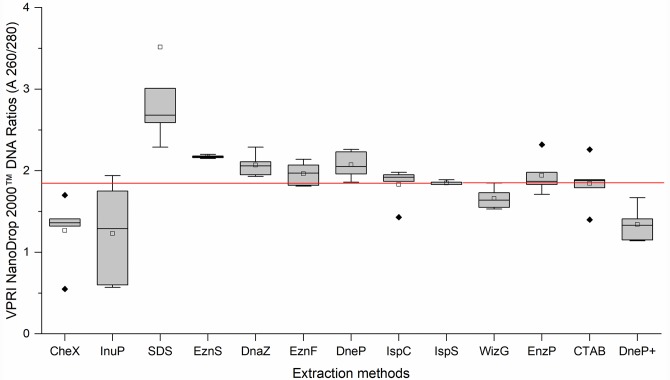
Boxplots of the DNA quality measured by thermo scientific nanodrop 2000™ absorbency measurement 260 nm / 280 nm ratios of five victorian plant pathology herbarium (VPRI) apple powdery mildew specimens produced by 13 DNA extraction methods.The red line indicates the desired target absorbency ratio 1.8–1.9. Median line __; Mean □; Outlier ◆ Extraction method abbreviations: Chelex®100 (CheX), innuPrep Plant DNA (InuP), sodium dodecyl sulphate (SDS), E.Z.N.A.® SP Plant (EznS), DNAzol™ (DnaZ), E.Z.N.A.® Forensic DNA (EznF), Qiagen DNeasy® Plant (DneP), Isolate II Plant DNA Lysis buffer PA1 C (IspC), Isolate II Plant DNA Lysis buffer PA2 S (IspS), Wizard® Genomic DNA Purification (WizG), E.Z.N.A.® Plant (EznP), Cetyl trimethyl ammonium bromide (CTAB) and Qiagen DNeasy® Plant plus PTB (DneP+).